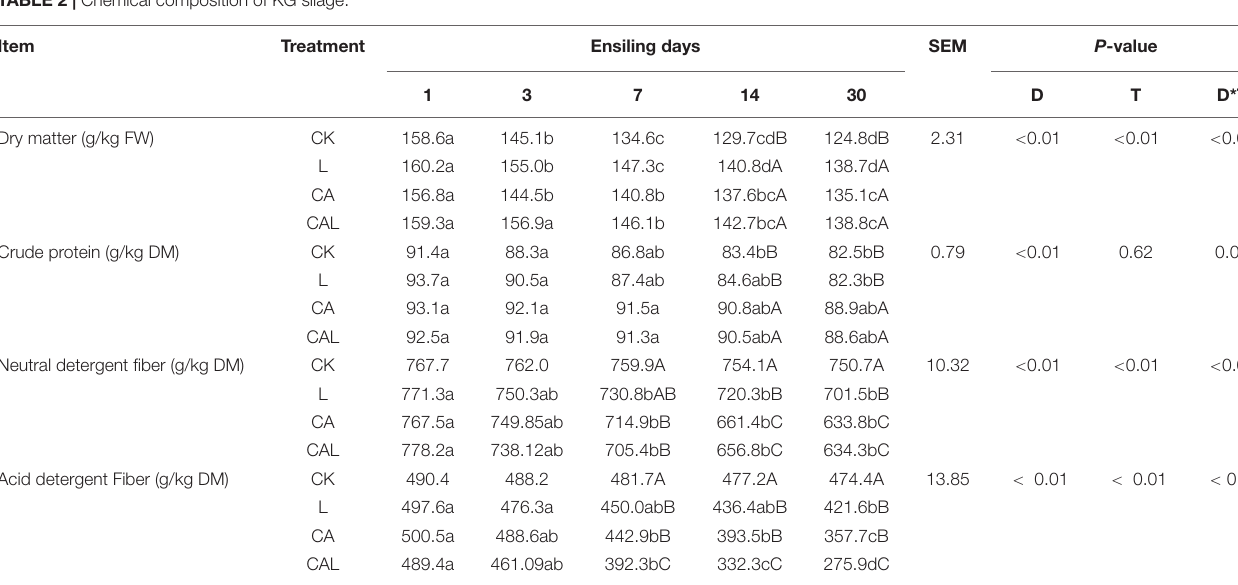
TABLE 2 | Chemical composition of KG